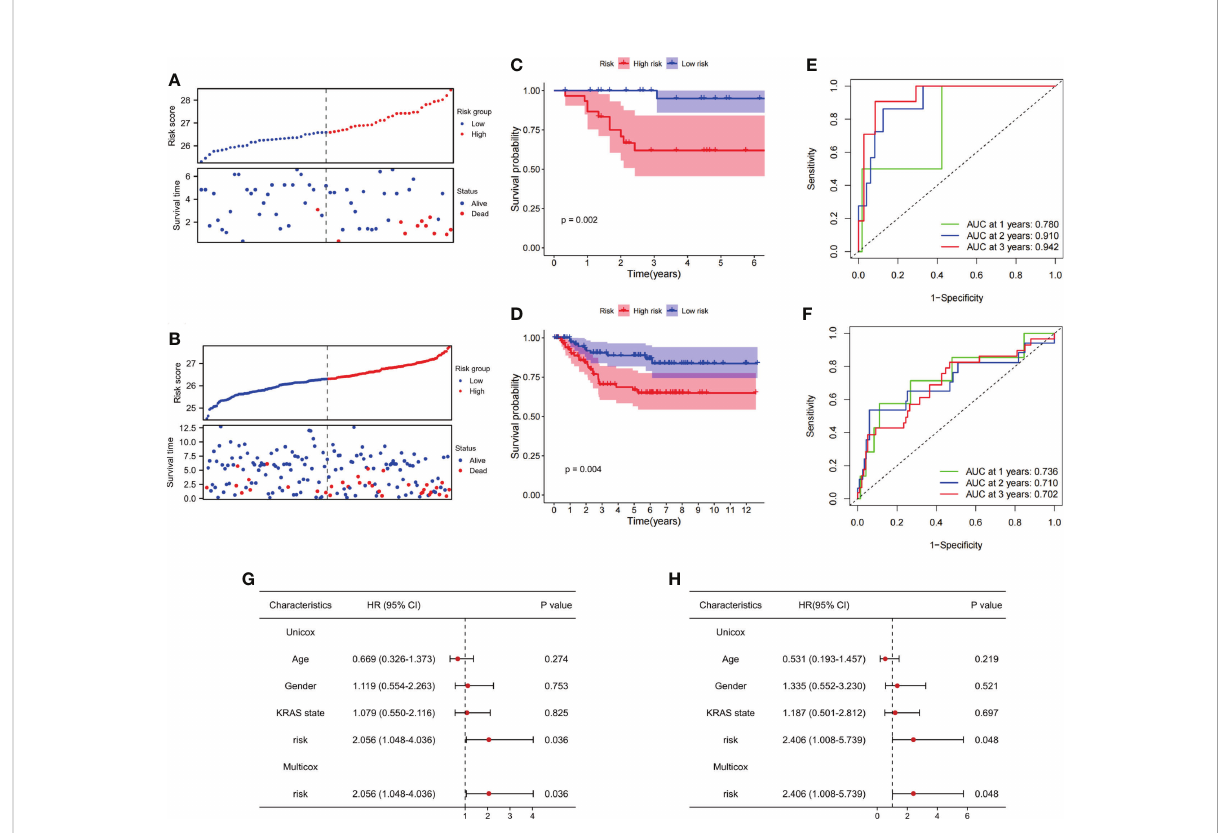
FIGURE 4 Evaluation of the ability of FAM-related signatures to predict prognosis in training and validation cohorts. (A, B) The association between DFS and FAM-related risk score in the training cohort (GSE56699) and the validation cohort (GSE87211). (C, D) Kaplan – Meier survival analyses of DFS between patients with high-risk scores and low-risk scores in the training and validation cohorts. (E, F) Time-dependent ROC curves used to evaluate the prognostic value of risk score in training and validation cohorts. (G) Univariate Cox analysis and multivariate Cox analysis of clinicopathological features and FAM-related signature in DFS. (H) Univariate Cox analysis and multivariate Cox analysis of clinicopathological features and FAM-related signature in OS. FAM, fatty acid metabolism; DFS, disease-free survival; ROC, receiver operating characteristic. OS, overall